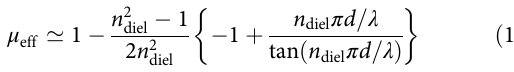
normal incidence ( z direction in Fig. 2c), the displacement